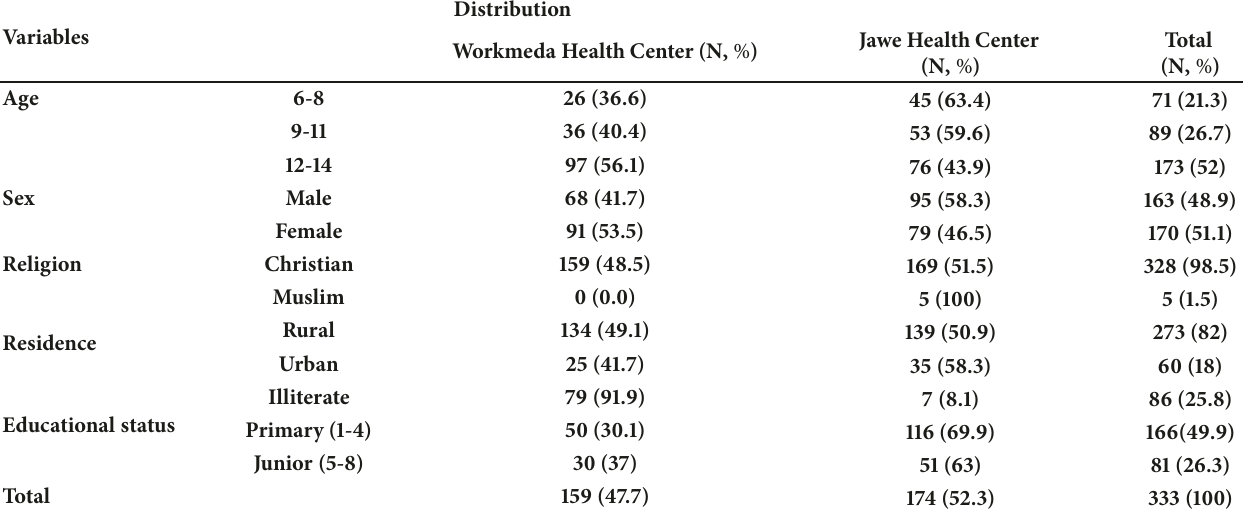
Table 1: Demographic characteristics of school age children in Northwest Ethiopia,